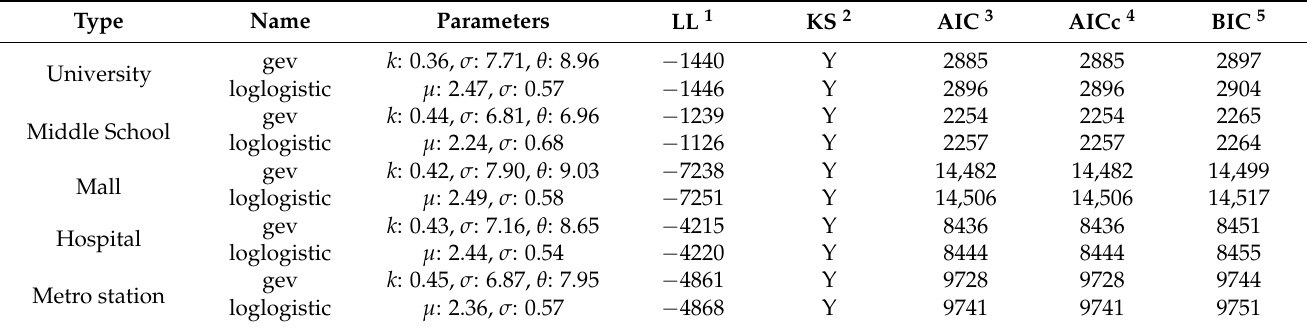
Table 4. Probability distribution parameters and goodness-of-fit test